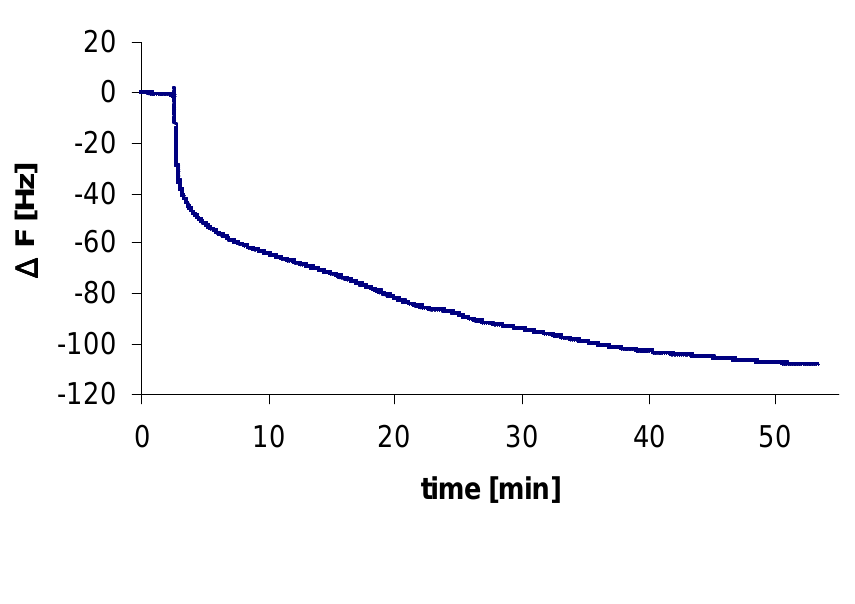
Figure 3 . Frequency response of QCM electrode modified with 3,3’-dithiodipropionic acid di(N- succinimidyl ester) in the presence of avidin (0.2